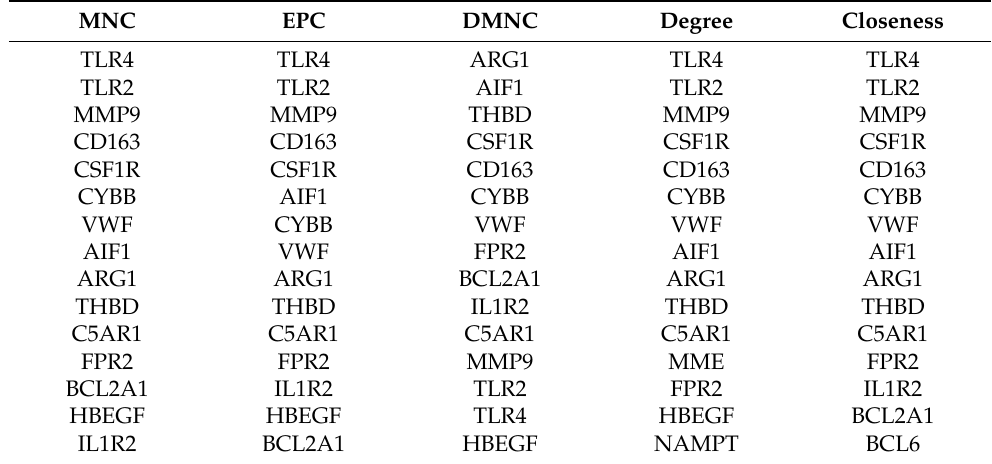
Table 1. The top 10 hub genes analyzed by cytoHubba.